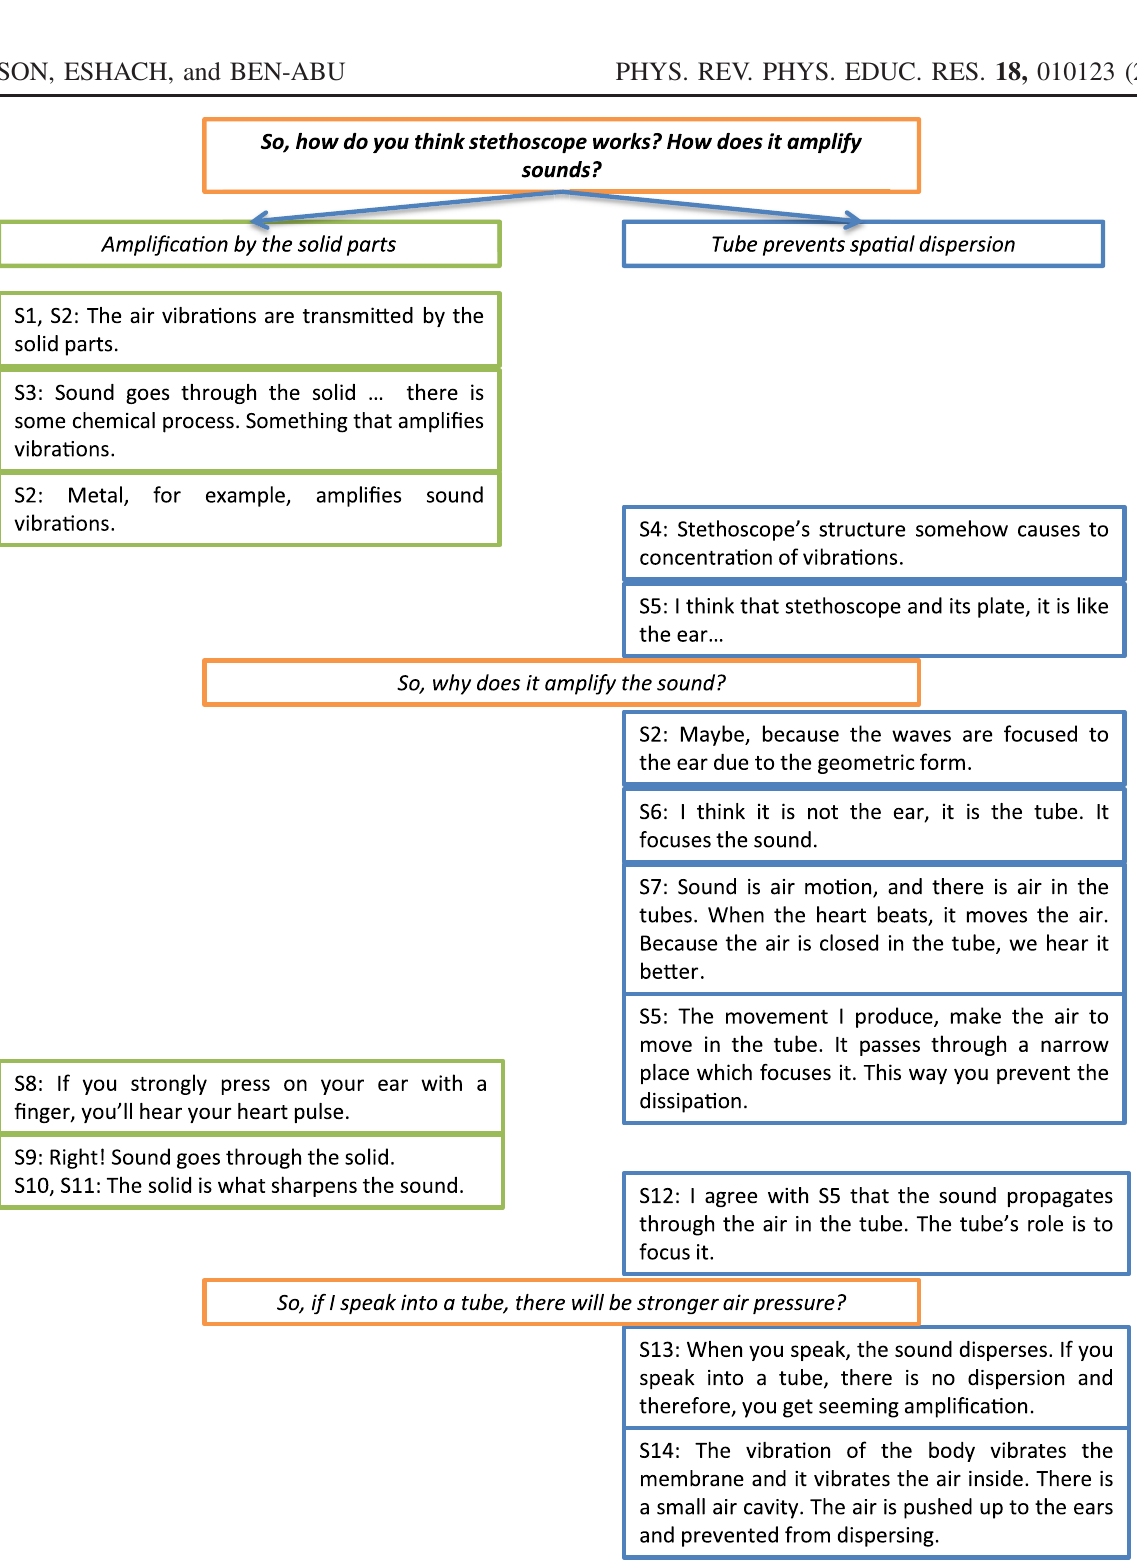
FIG. 4. WCDD about the physical principles of a stethoscope ’ s work. The lecturer ’ s interventions are shown in the orange boxes; amplification by solid parts responses are shown in the green boxes; prevention of spatial dispersion are shown in the blue boxes. The CFDM is characterized by the accumulation around two budding foci concepts